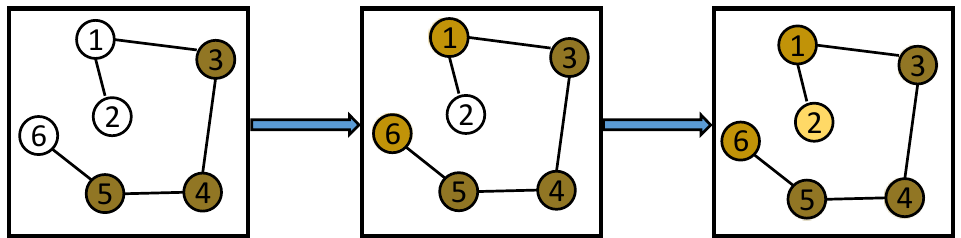
Figure 5. Enlarging respective fields. With stacked layers, agent 4 first obtains the information of agents 3 and agent 5, then obtains the information of agents 1 and 6, and finally obtains the information of agent